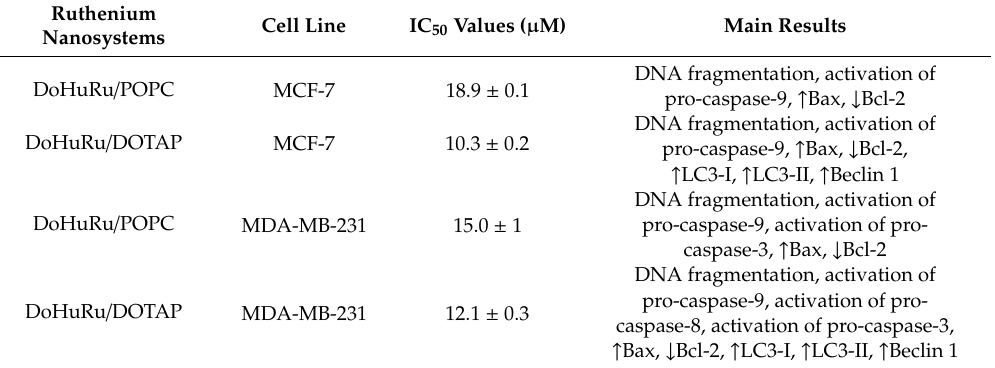
Table 2. Main biological e ff ects observed at both nuclear and cytosolic level (with particular reference to mitochondria) throughout preclinical test in ER (MCF-7) and TN (MDA-MB-231) breast cancer (BC) models following incubations with the indicated neutral (POPC) and cationic (DOTAP) nanoformulations